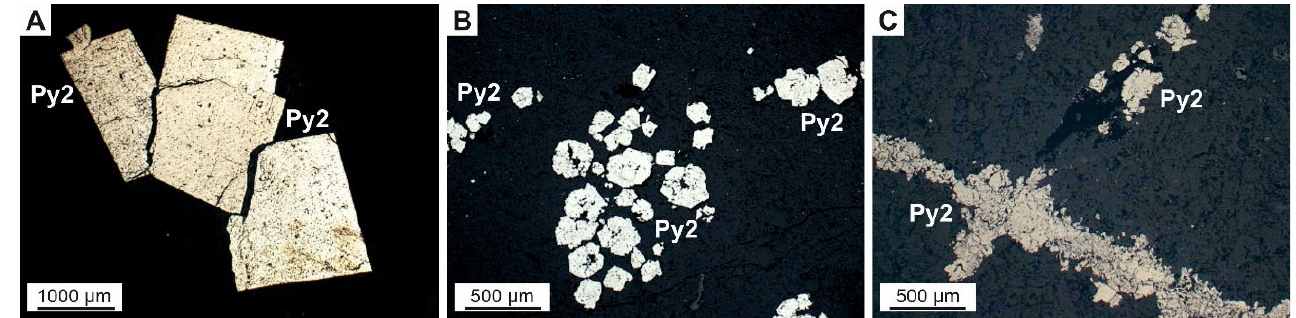
Figure 9. Microtextures of metamorphic pyrite2 (reflected light) OGDs, central YKMB: ( A ) inter- growths of cubic pyrite; ( B ) accumulation of crystals and pyrite intergrowths. The central part of the individual grains is corroded; ( C ) micro-veinlets of pyrite along